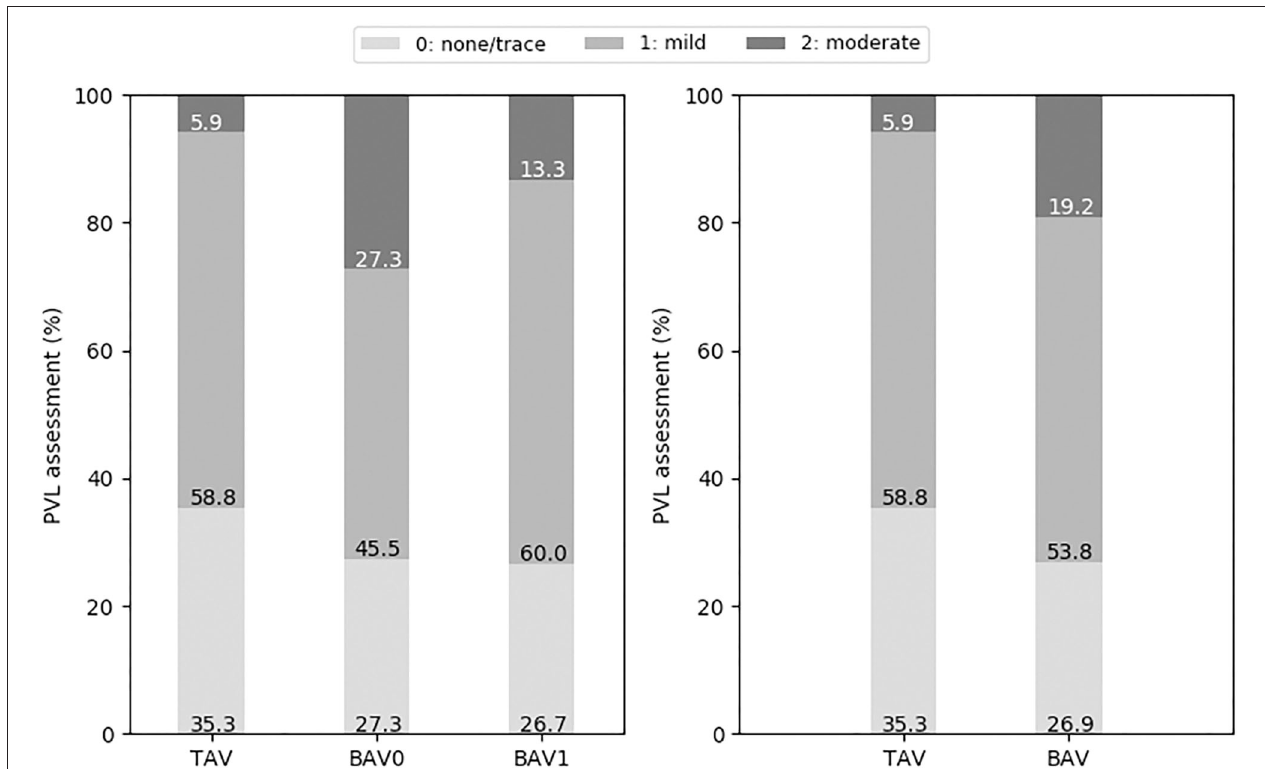
FIGURE 5 | Post-operative PVL grading (none or trace, mild, and moderate) for the different types of valve morphologies: TAV, BAV, BAV0, and